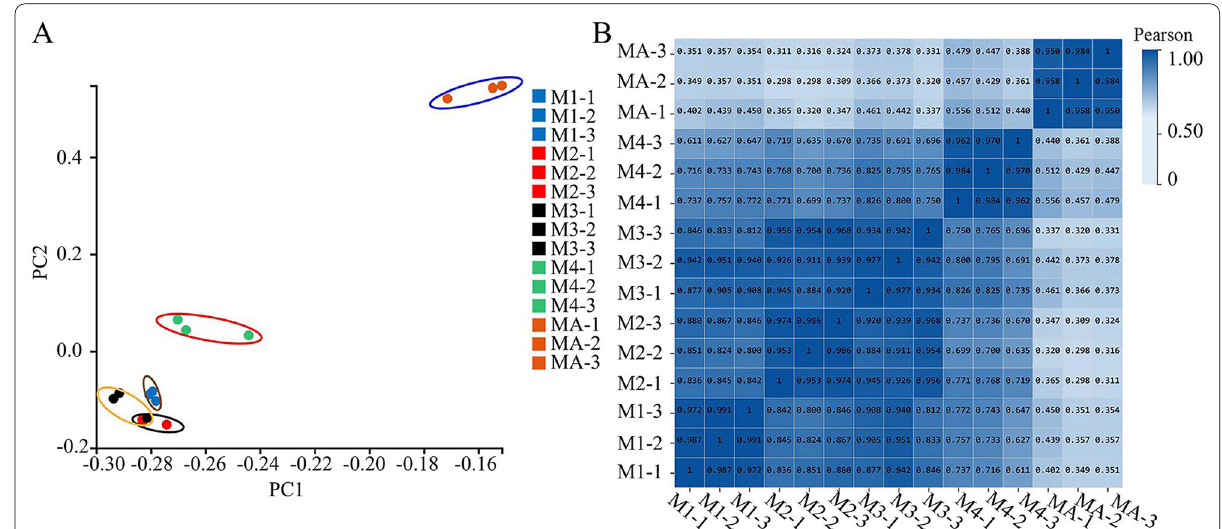
Fig. 4 Principal components analysis and sample relationship heatmap of RNA-seq data. Samples from M1 (M1_1, M1_2, M1_3), M2 (M2_1, M2_2, M2_3), M3 (M3_1, M3_2, M3_3), M4 (M4_1, M4_2, M4_3) and MA (MA_1, MA_2, MA_3) were clustered into 5 groups, respectively. M1, M2, M3, M4 and MA represent the 1st, 2nd, 3rd, 4th instar nymph and adult, respectively ( A ). In the heatmap, dark green represents strong correlation, and light green denotes weak correlation. Each column and row correspond to one sample’s relationships with the other 18 samples including itself ( B